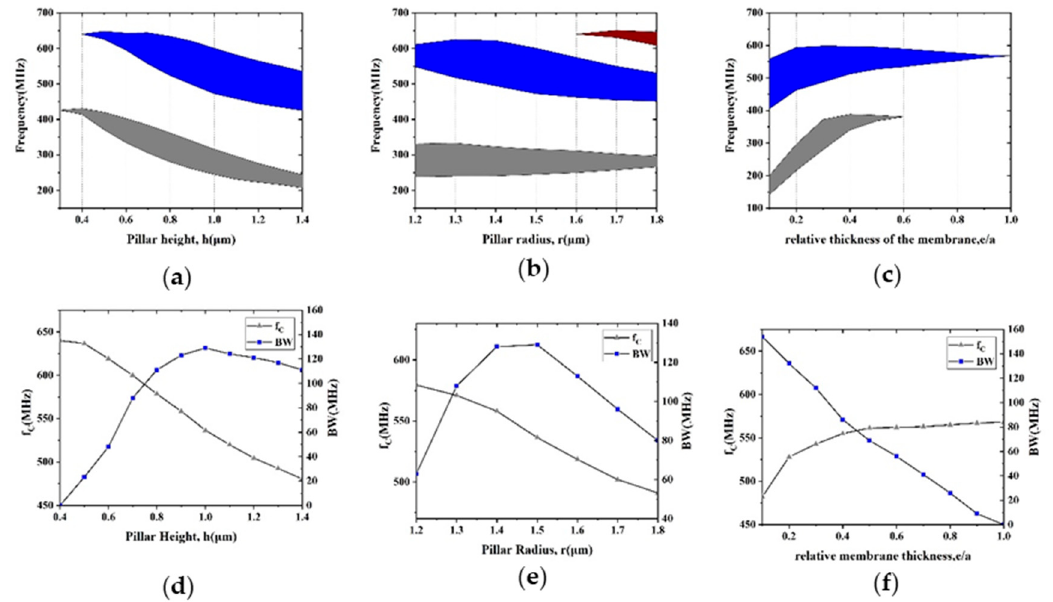
Figure 5. The dependence of the bandgap ranges on the ( a ) pillar height h , ( b ) pillar radius r and ( c ) relative membrane thickness. Characteristics of the second bandgap change with ( d ) pillar height h and ( e ) pillar radius r ( f ) relative membrane thickness.